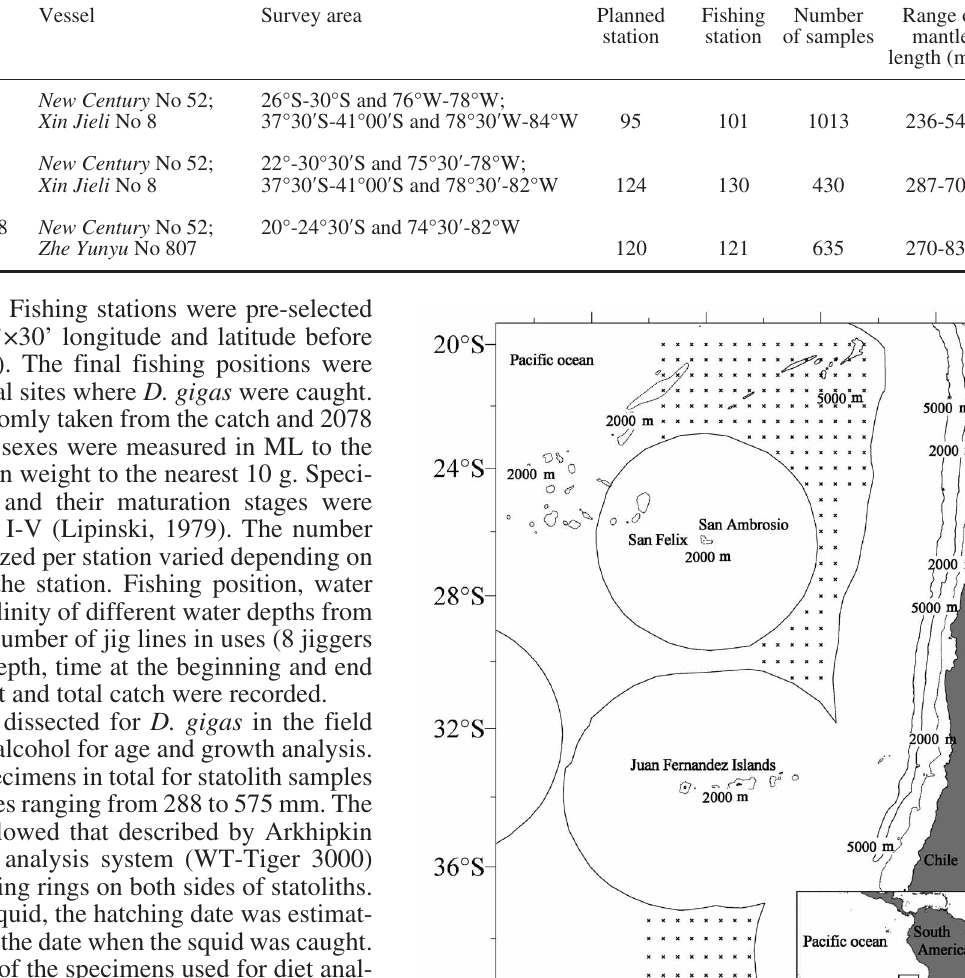
Table 2. – Summary of the survey areas and sample collection of Dosidicus gigas between April 2006 and May 2008. Survey